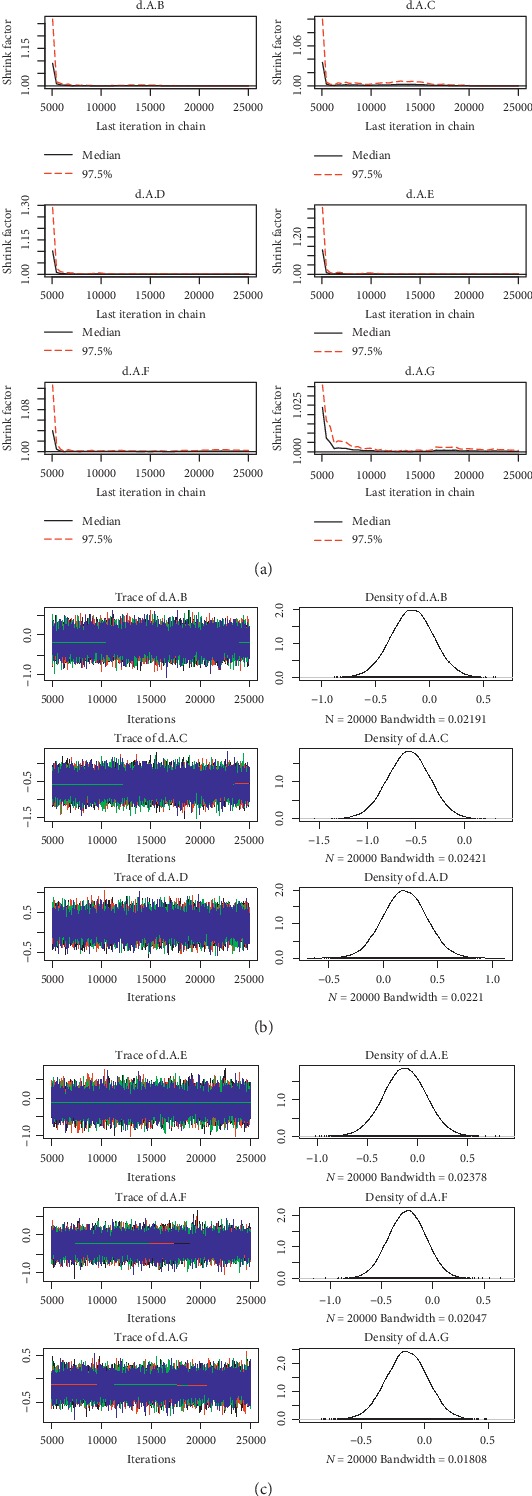
Brooks-Gelman-Rubin diagnostic plot and density plot for the efficacy of the comparison among different treatments of patients with moderate renal function.